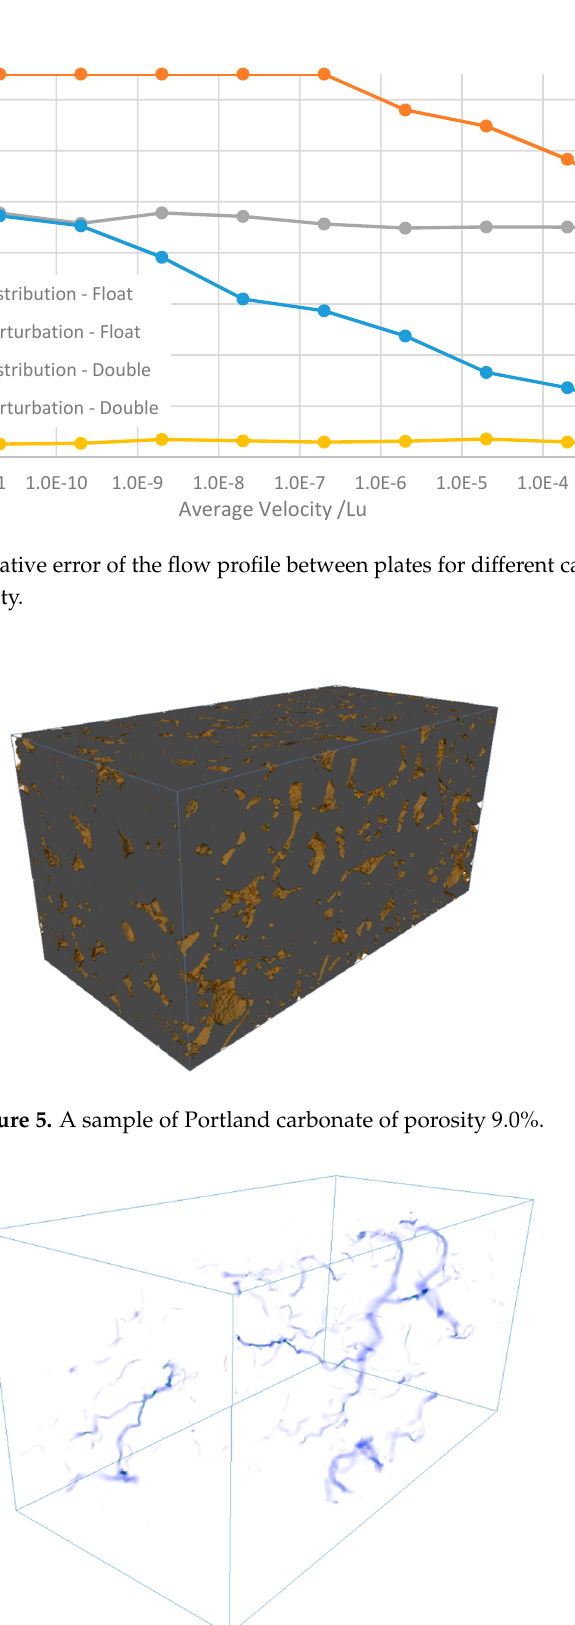
Figure 6. The velocity distribution computed in the pore space image of the Portland carbonate sample.